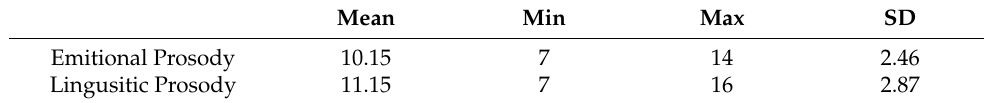
Table 2. Emotional and linguistic prosody.